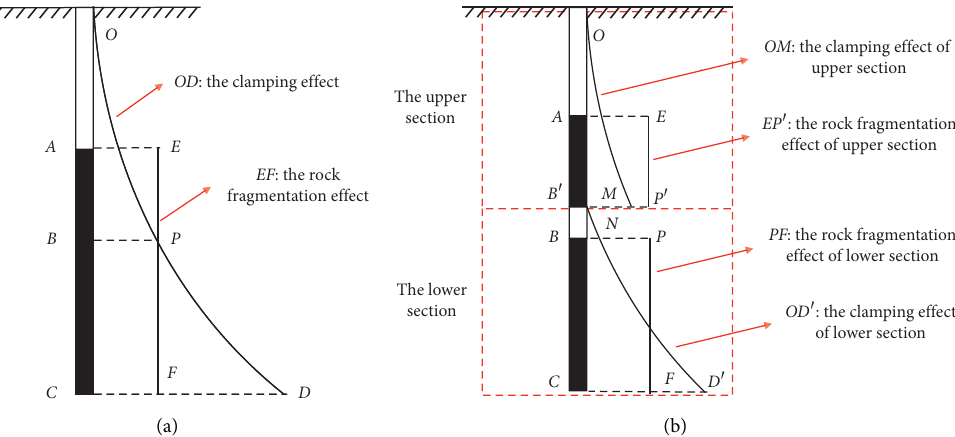
Figure 3: Curves of the clamping effect and the rock fragmentation effect along with the depth. (a) One-step blasting. (b) Two-step blasting. ((a) and (b) show the difference between one-step cutting blast and two-step cutting